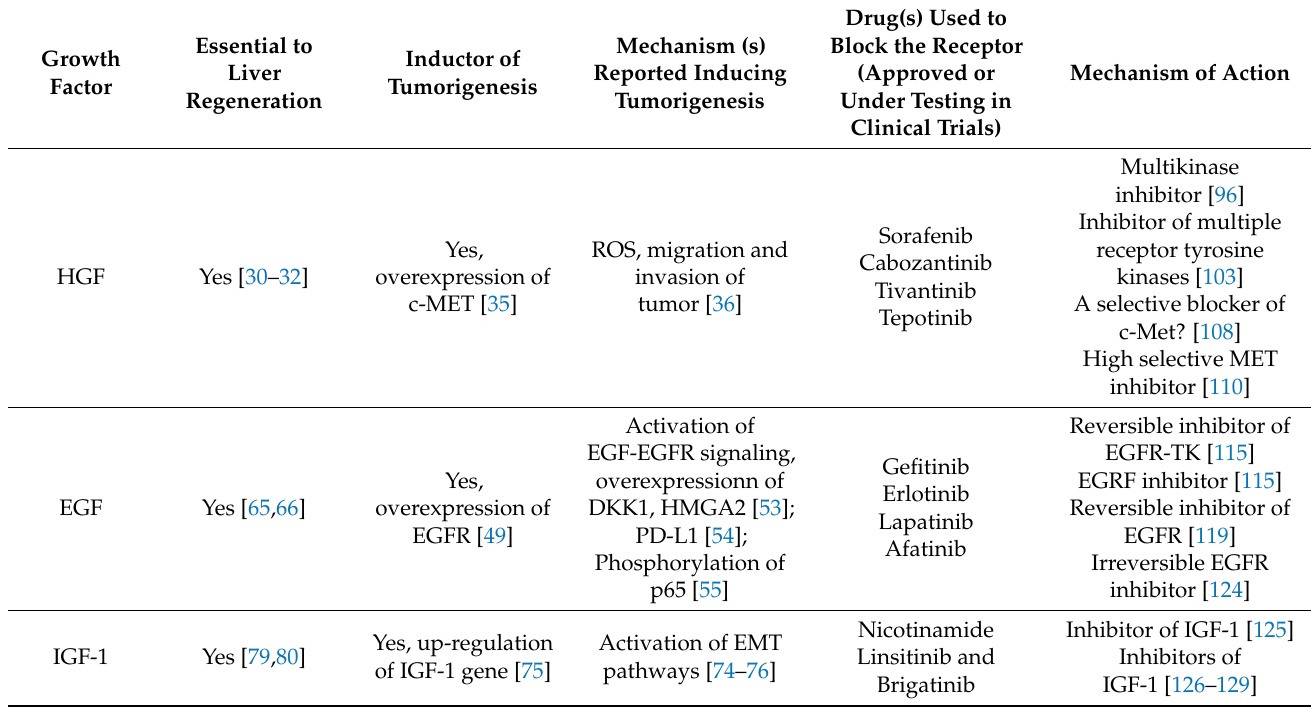
Table 1. Overview of the pharmacological approach with HGF, EGF, and IGF-1 in liver regeneration and tumorigenesis.